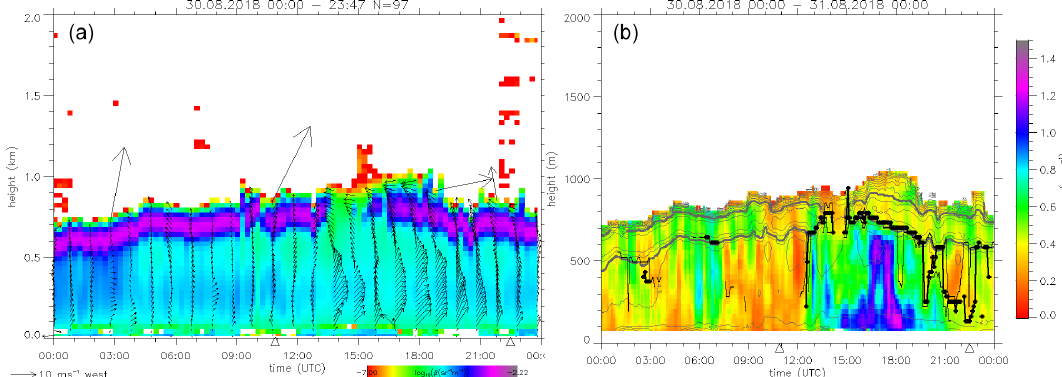
Figure A1. Example data from 30 August 2018. (a) Horizontal wind speed and direction (vectors) and attenuated backscatter ( β , color shading) as a function of time and height. (b) Standard deviation of vertical velocity from the wind lidar (color shading) and backscatter (log 10 β , thin gray lines), with log 10 β = − 5 as a typical value for cloud-base (thick gray line) and mixing-layer height estimates (after Schween et al., 2014, thick black line with symbols). Note that the upper border of the region with backscatter is due to extinction of the laser signal and does not represent the cloud top. Triangles at the abscissa indicate the times of sunrise and sunset with night to the left and day on the right-hand side.